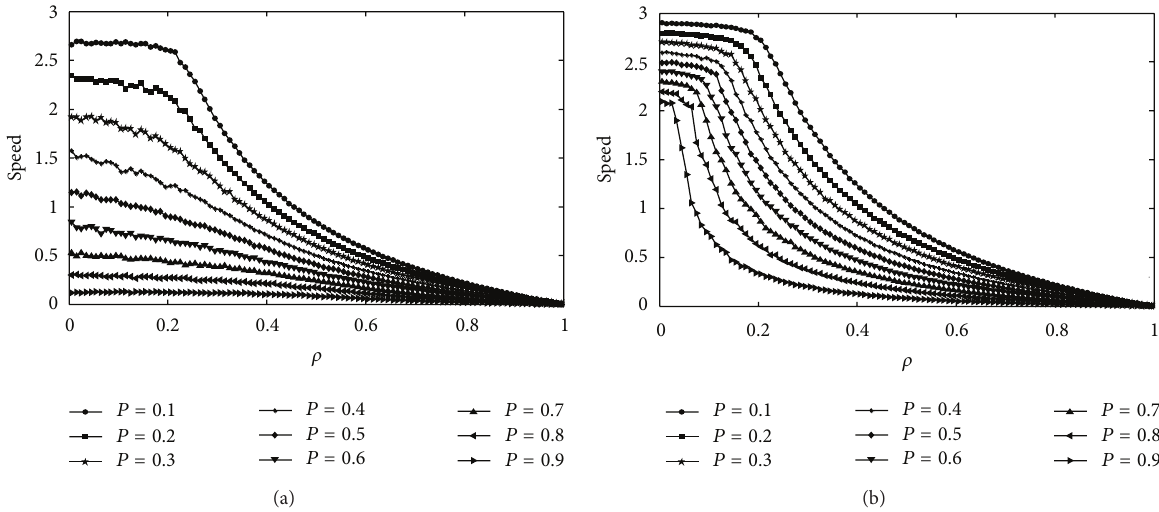
Figure 2: Relationship between traffic speed and 𝜌 : (a) heavy fog condition and (b) normal weather condition.